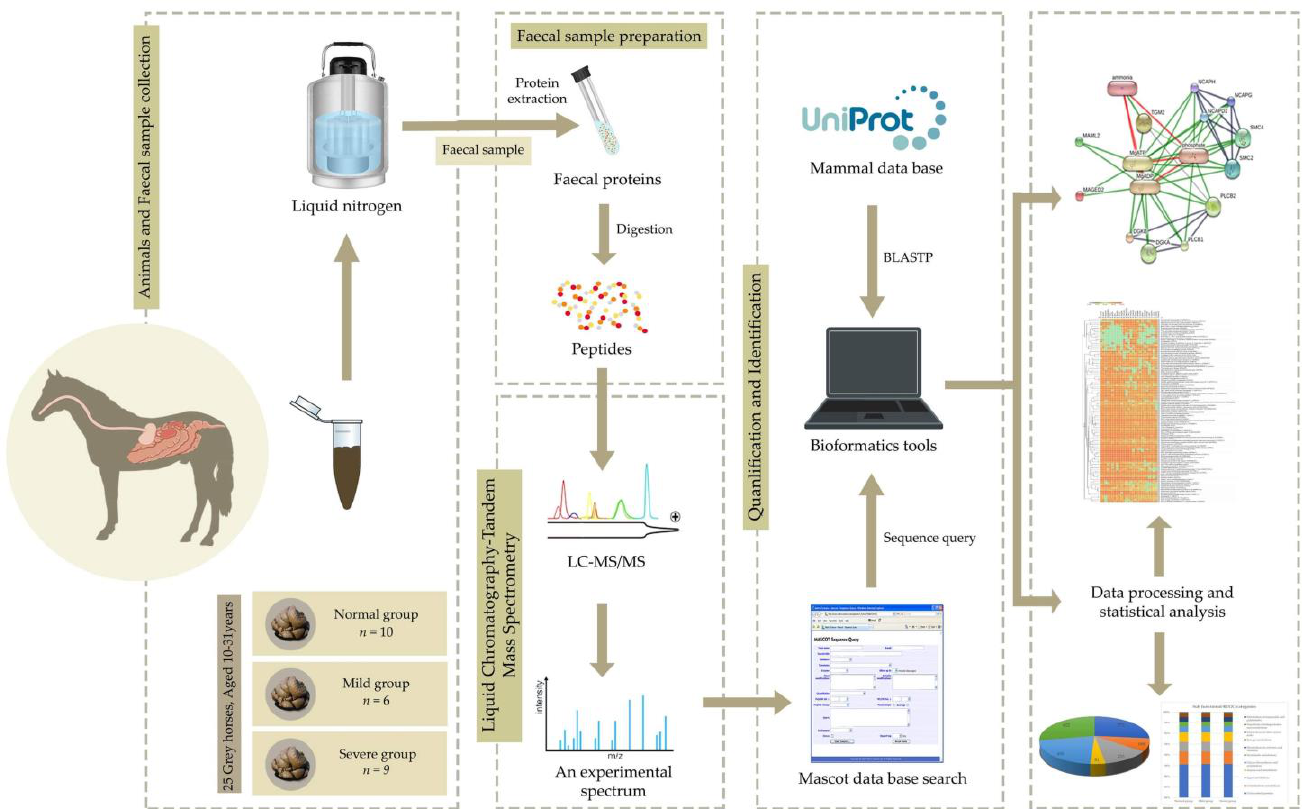
Figure 1. The proteomic framework from EMN faecal sample towards protein identification and Figure 1. TheproteomicframeworkfromEMNfaecalsampletowardsproteinidentificationandquantification. quantification.